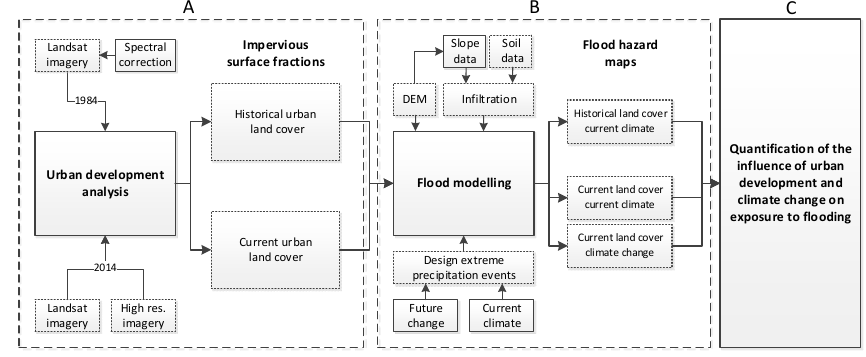
Figure 1. Schematic of the methodology for quantifying the influence of changes to urban land cover and climate change on exposure to pluvial